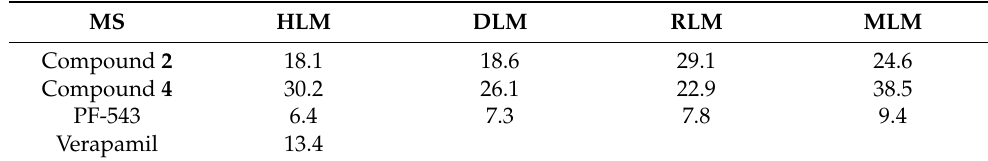
Table 2. Metabolic stability of 2 , 4 , and PF-543.